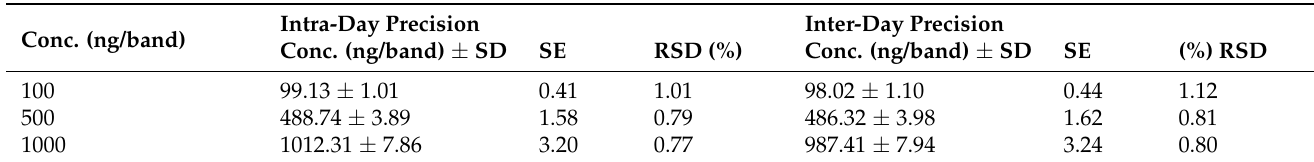
Table 4. Determination of CDN intra-day and inter-day fluctuation for current protocol (mean ± SD; n = 6).